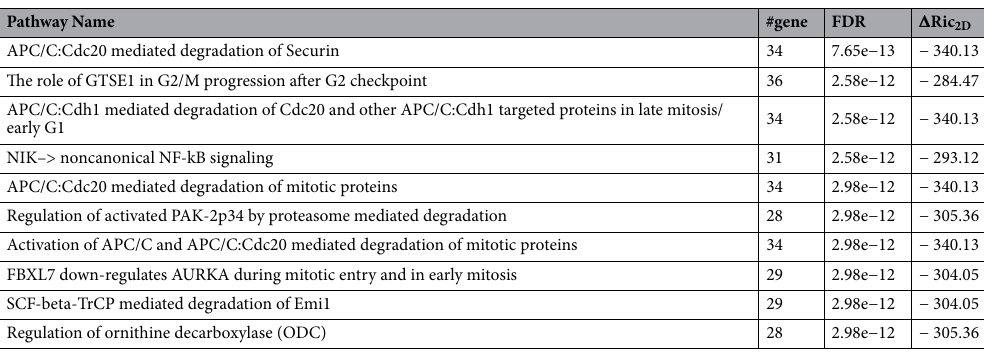
Table 3. Decreased PPI curvature pathways in melanoma. Using vertex curvature of the 2D PPI network model, genes with significantly decreasing curvature values compared between normal and tumor cells were fed into Reactome Pathway Analysis. Top 10 enriched pathways are summarized by pathway name, number of significant genes, false-determination rate (FDR), and average shift in curvature ( (cid:31) Ric 2D